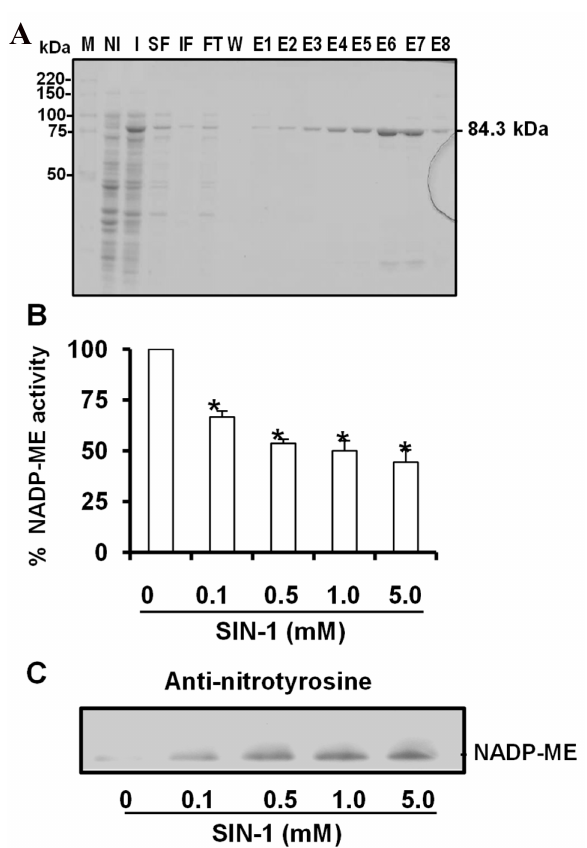
Figure 4. Purification of recombinant cytosolic NADP-ME2 and effect of SIN-1 (3-morpholinosydnonimine (peroxynitrite donor)) on its activity. ( A ) Purity of recombinant NADP-ME after expression and purification was evaluated by SDS-PAGE (10%) and Coomasie blue staining. M, molecular markers; NI, total protein in no-induced culture; I, total protein in induced culture; SF, soluble fraction; IF, insoluble fraction; FT, flow-through; W, wash; E1-E8, elution fractions. ( B ) Effect of SIN-1 on recombinant NADP-EM2 activity. ( C ) Representative immunoblot showing the degree of tyrosine nitration of NADP-EM2 treated with different concentrations of SIN-1 and detected with an antibody against 3-nitrotyrosine (dilution 1:2500). 3 µ g of protein was used per line. The specific activity of recombinant NADP-ME was 9850 µ mol NADPH min − 1 mg − 1 protein. Data are the means ± SEM of at least three replicates. * Differences from the control values were significant at p <